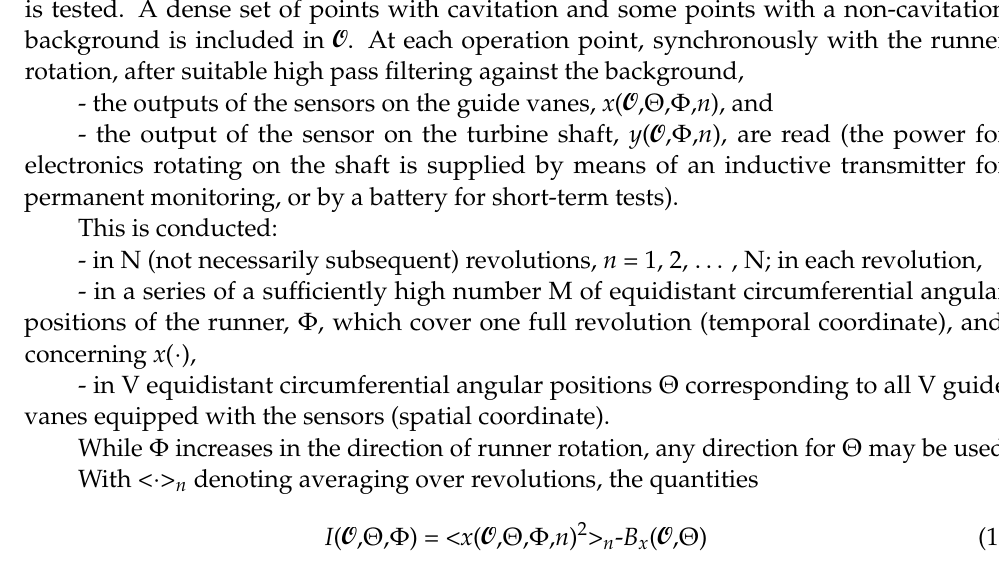
Figure 3. Front panel of the multidimensional data acquisition processor. The simplest description of cavitation comes out online after half an hour of measurement on the prototype. More compli- cated descriptions require days or weeks of recorded data analysis by a trained user.